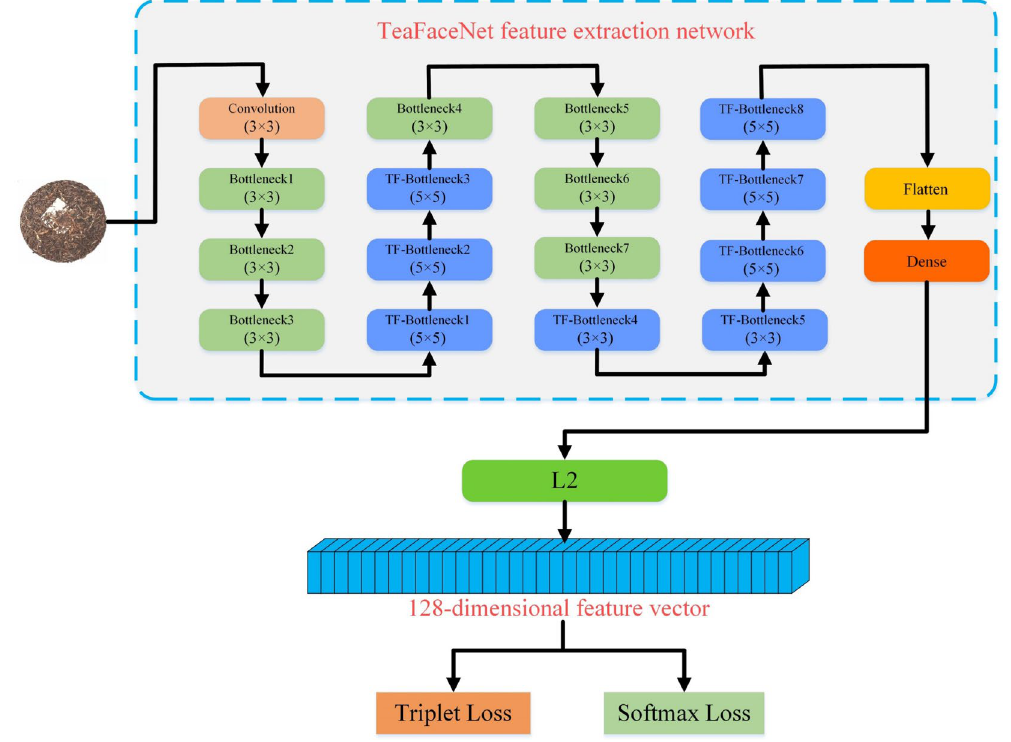
Figure 8. The training structure of the TeaFaceNet model.